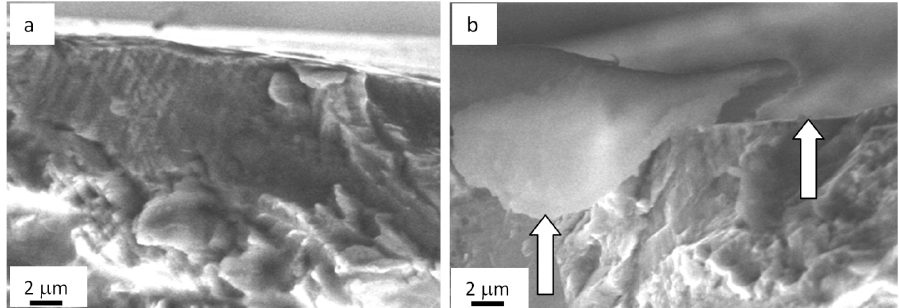
Figure 7. Fractography of the fatigue-fractured surface in AISI 310S steel treated with an electron beam and fractured when fatigue testing. ( a ) columnar structure. Arrows ( b ) indicate a film on the surface of steel irradiated with an electron beam.